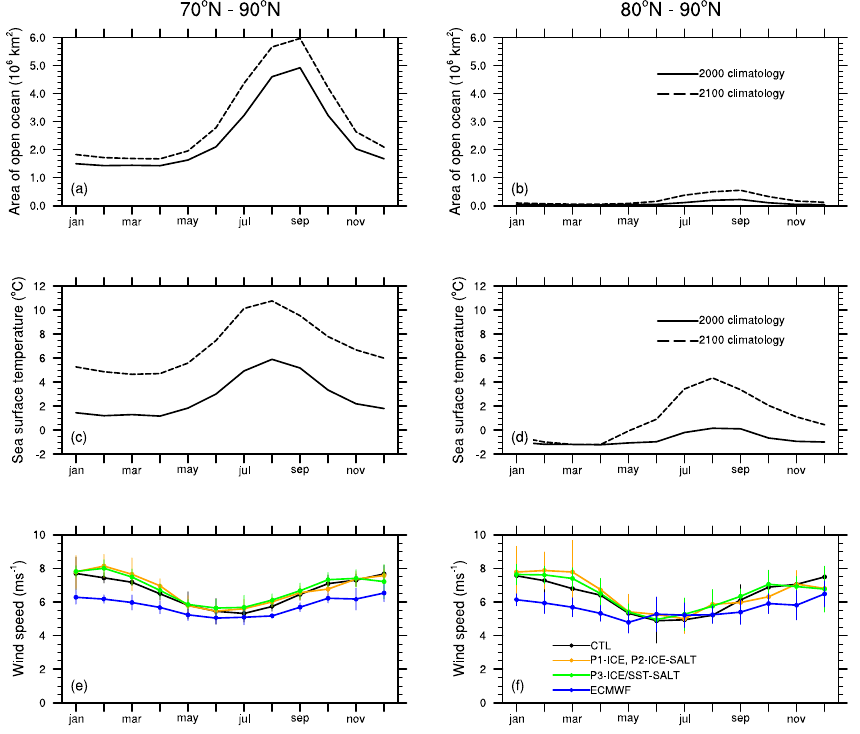
Fig. 5. Fields determining the emission of sea salt aerosol in the model. (a) , (b) prescribed total open ocean area, (c) , (d) prescribed sea surface temperature and (e) , (f) monthly average U 10 (70 to 90 ◦ N (left hand panels) and 80 to 90 ◦ N (right hand panels)). Only grid points over ocean are included in the averaging of the U 10 which are taken over the final five years of the model simulations. Blue lines in (e) and (f) are monthly mean U 10 (2000–2005) from the ECMWF ERA-Interim data set. Vertical lines indicate the two standard deviations corresponding to the monthly